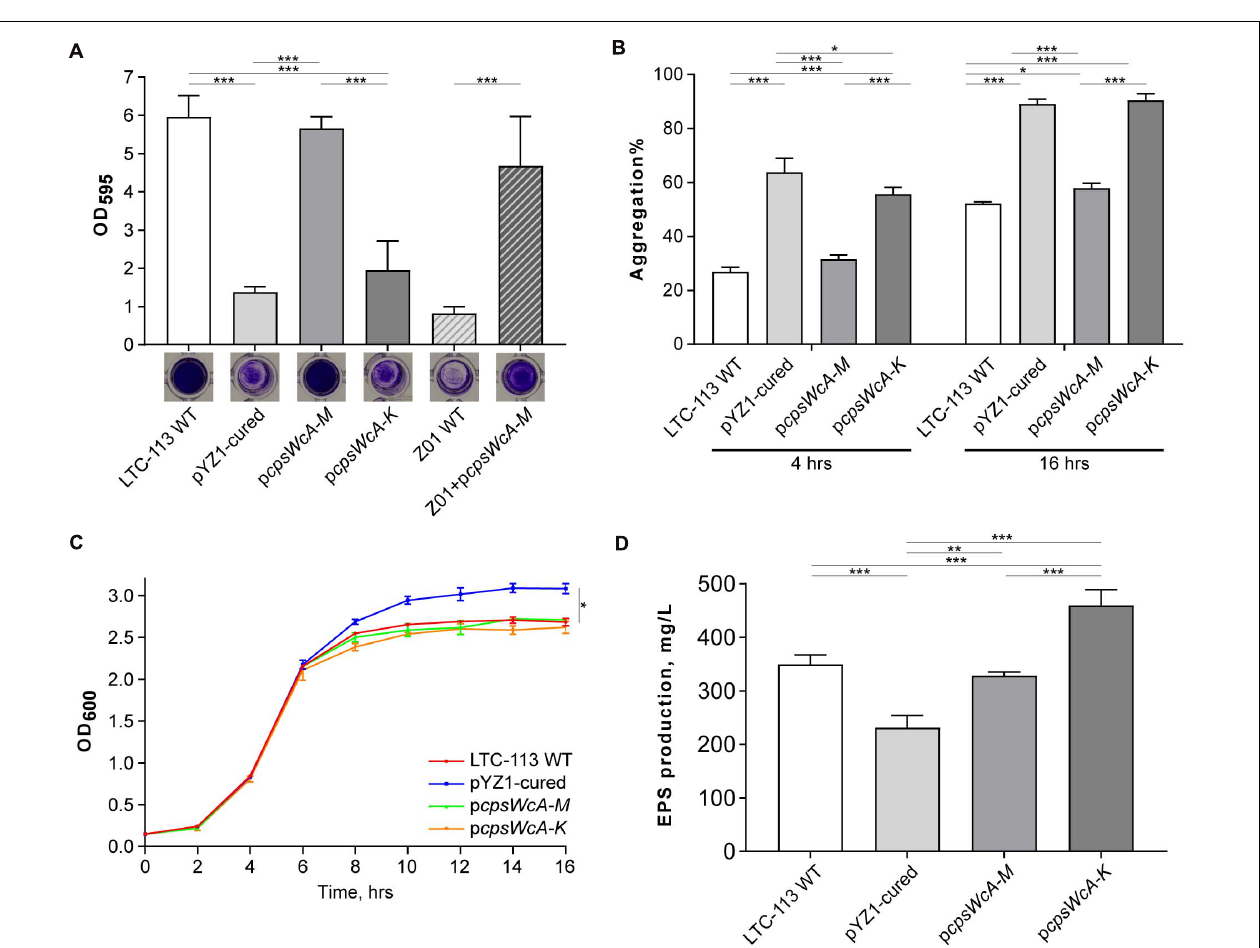
FIGURE 2 | Biochemical characterizations of LTC-113 and its derivative strains. (A) The biofilm formation ability of LTC-113 and its derivative strains. (B) The bacterial aggregation of LTC-113 and its derivative strains at 4 and 16 h. (C) The growth curve of LTC-113 and its derivative strains during a 16-hour time course. (D) The concentration of supernatant EPS of LTC-113 and its derivative strains. Values represent mean ± SD of the mean; * P < 0.05; ** P < 0.01; *** P < 0.001.